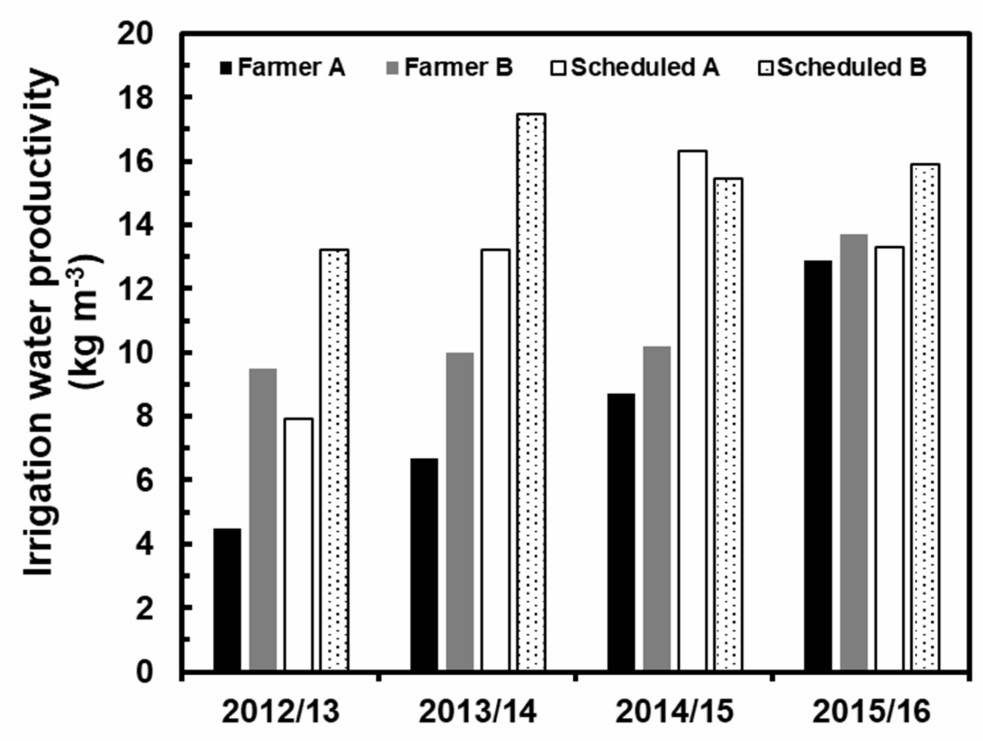
Figure 9. Irrigation water productivity by Farmer A, Farmer B, and irrigation scheduled by IFAPA in both